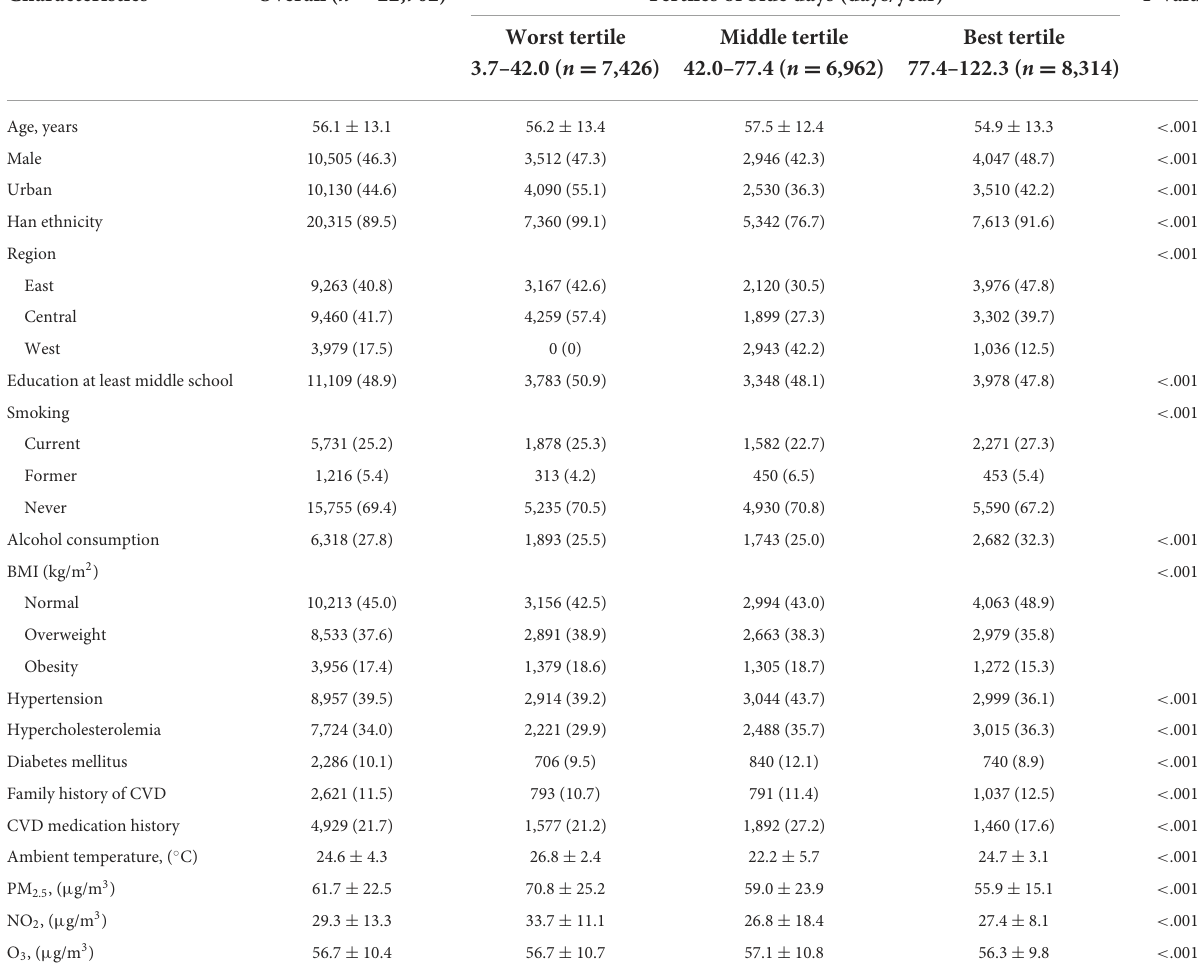
TABLE 1 Baseline characteristics of study